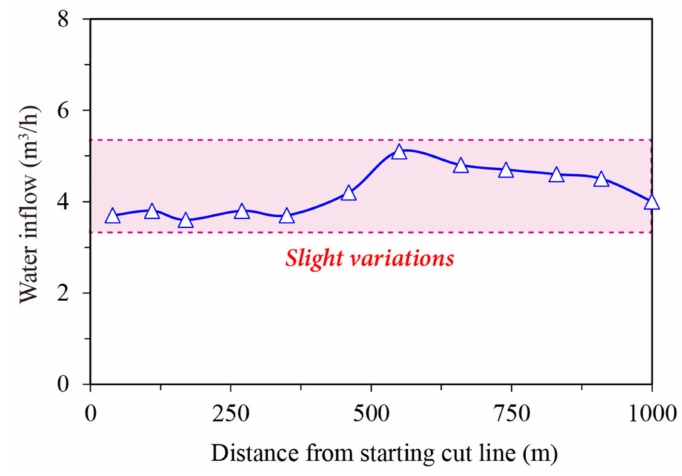
Figure 9. Variation law of water inflow with mining